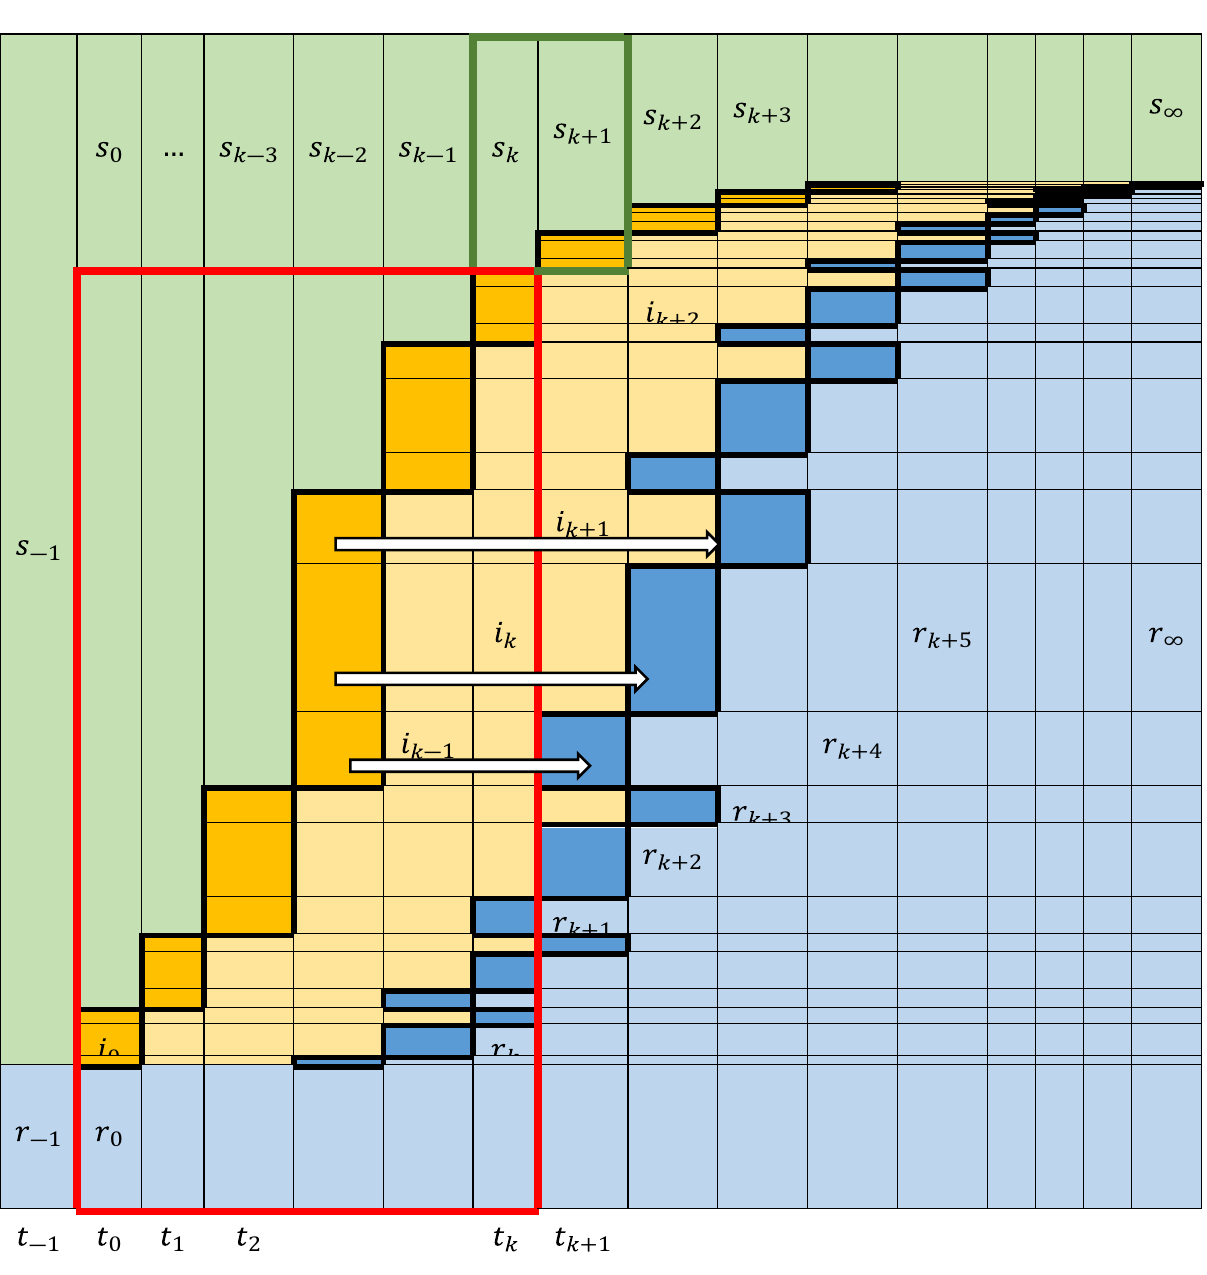
which, combined with the infectivity Eq. (1) and the consistency Eq. (4) forms a general representation of the SIR system dynamics 29,32 . Selecting F in Eq. (7) to be the cumulative density function of the exponential distribution